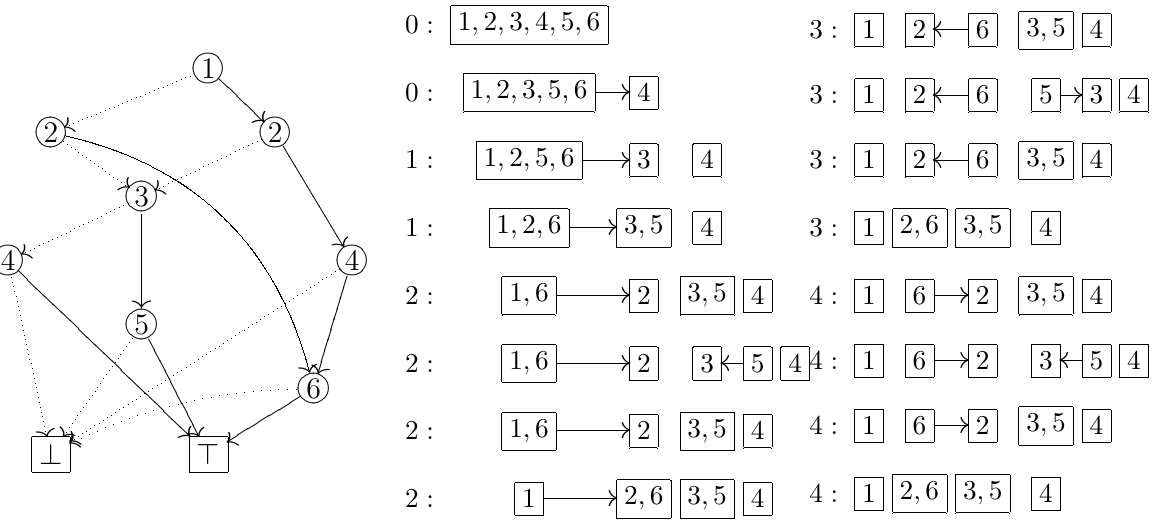
Figure 3. The computing process of our algorithm for the ZDD that represents the set family {{ e } ; { e } ; { e } ; { e } ; { e } ; { e }} is shown below. For example, ; e ; e ; e ; e ; e ; e ; e ; e 4 3 5 2 6 1 4 1 3 5 1 2 4 6 in the third line from the bottom of the left column, the number 2 on the left side means that ⊤ was visited twice; the right arrow means that the state of e changed from LO to HI; 2 the left arrow means that the state of e changed from HI to LO. In the bottom of the right 3 } ; { e } ; { e } ; { e }} is ; e ; e column, the co-occurrence partition {{ e 1 2 6 3 5 4